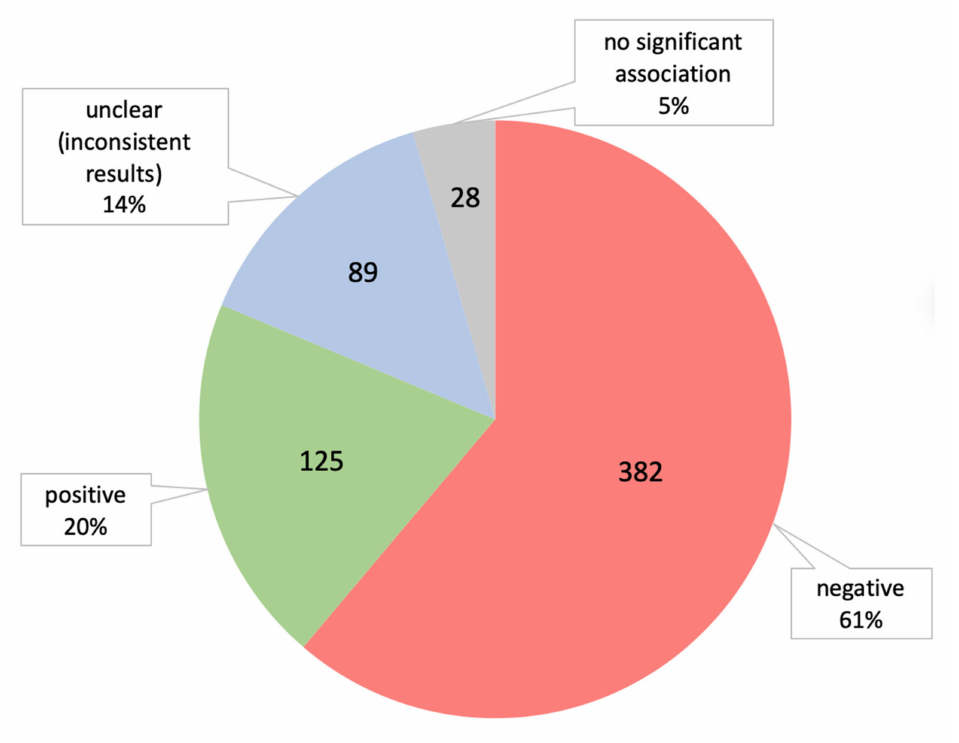
Figure 4. Type of association of factors with cognitive